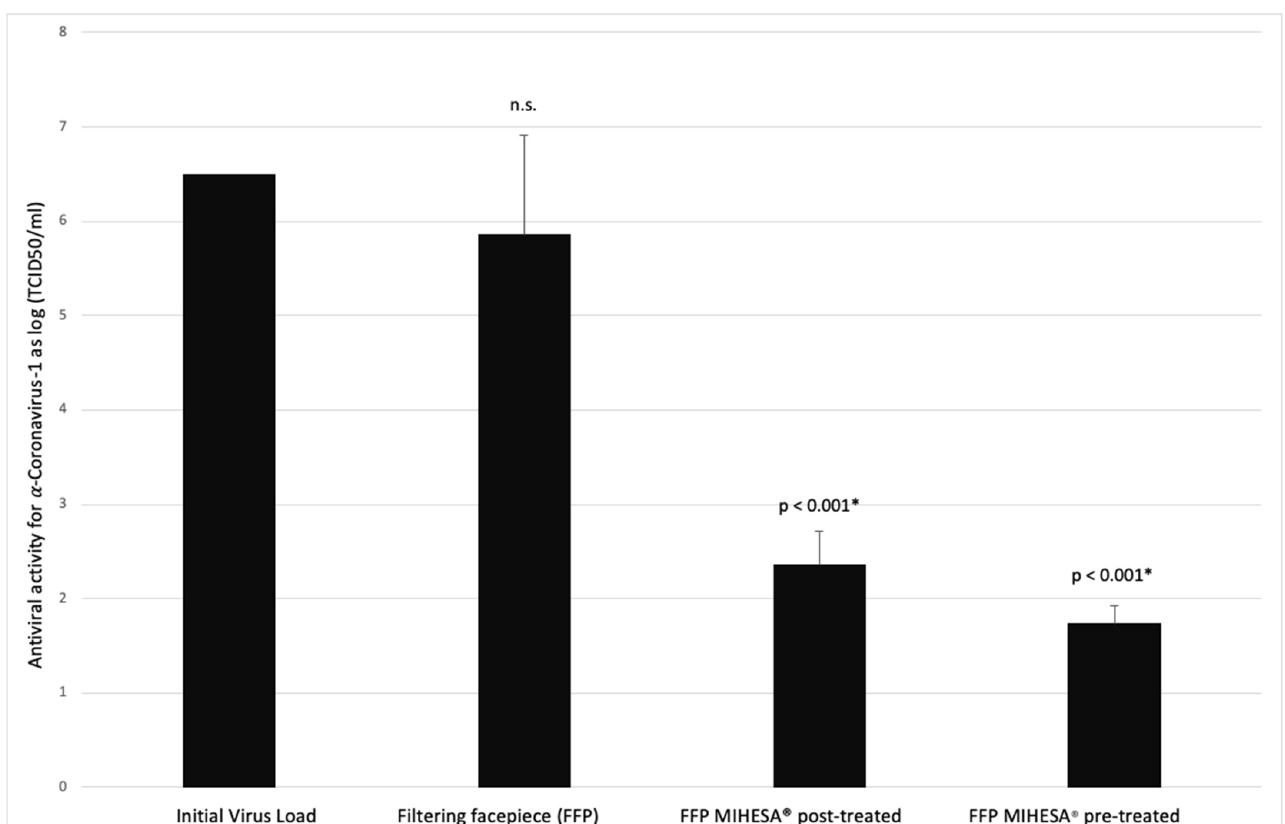
Figure 2. TGEV inhibiting activity (initial titer = 10 6.5 TCID 50 /mL) on bare FFP compared to FFP’s treated with hypertonic saline (MIHESA). n.s. = not significant; *: indicate the significance level.